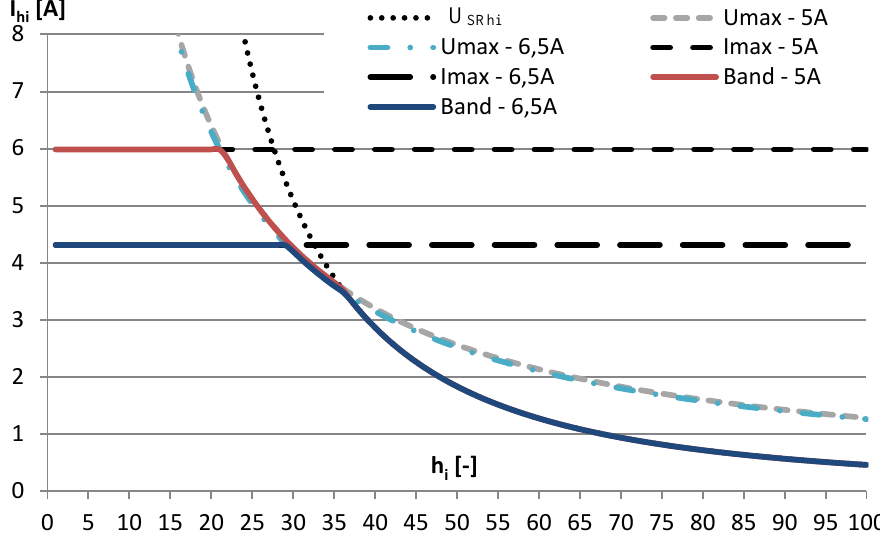
Figure 2. The maximum rms values of the higher harmonics of the output current able to be generated by the power source for a given rms value of the main harmonic of this distorted current equal to 6.5 A with load inductance equal to 5 mH.